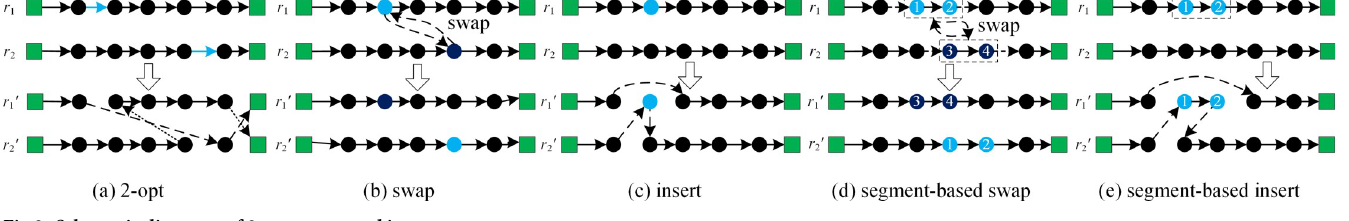
Fig 3. Schematic diagrams of 2-opt, swap, and insert